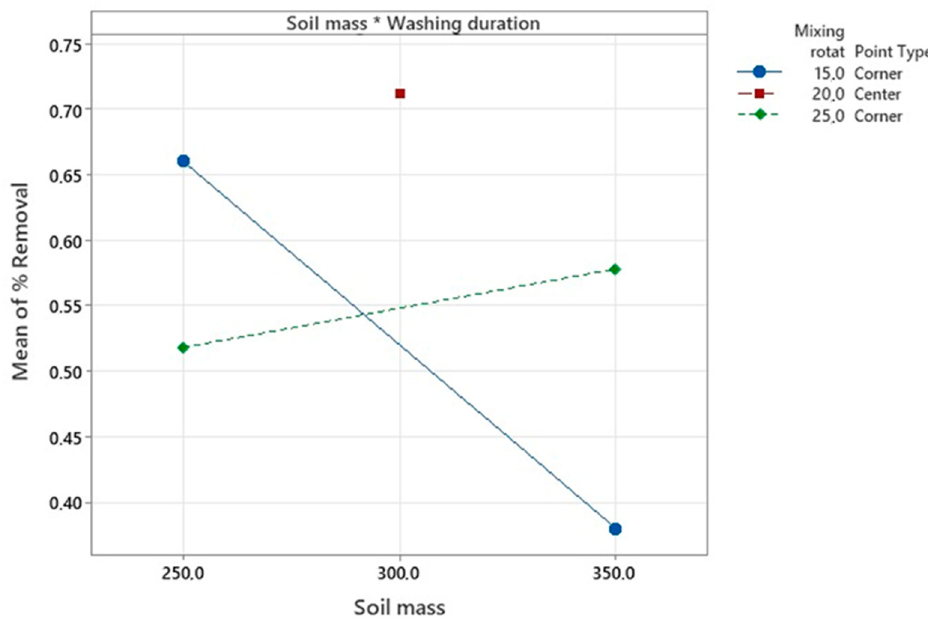
Figure 8. Interaction plot for oil removal (%) (fitted means). Soil mass * Washing duration refers to the interaction effect between these two variables.